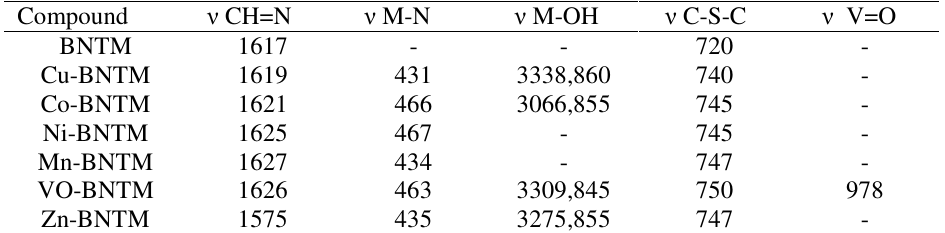
Table 2. Characteristic IR bands (cm -1 ) of the compounds studied